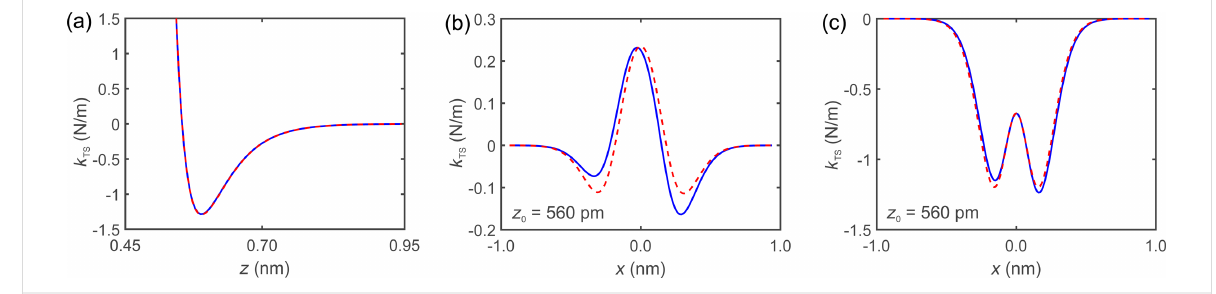
Figure 2: Simulated Morse potential interaction for a LFM setup and comparison to normal AFM. θ is defined by Equation 1. (a) Simulated force gradient ⟨ k ts ⟩ of a vertically oscillating tip above an atom with θ = 86° shown by the blue solid curve and without tilt ( θ = 90°) shown by the red dashed curve. The atom was simulated by a Morse potential. (b) ⟨ k ts ⟩ of a laterally oscillating tip above an atom with sensor tilt θ = 4° shown by the blue solid curve and without ( θ = 0°) shown by the red dashed curve at height z 0 = 560 pm. The height z 0 is defined according to Equation 5. The ratio of the difference between the minima of the curve with tilt and without tilt to the overall curve without tilt is 14.2%. (c) ⟨ k ts ⟩ of a vertically oscil- lating tip following the path of the laterally oscillating tip at the same height with a tilt ( θ = 86°, blue solid curve) and without a tilt ( θ = 90°, red dashed curve). The ratio of the difference between the minima of the curve with tilt and without tilt to the overall curve without tilt is